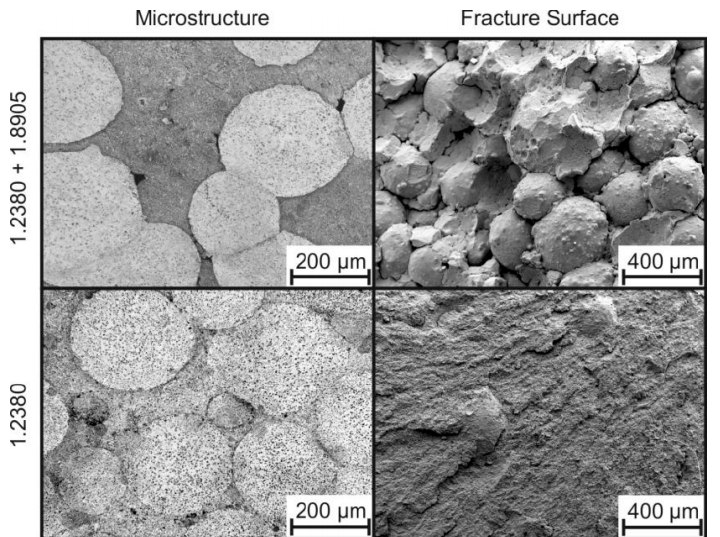
Figure 8. Comparison of the microstructure and the fracture surface of 1.2380/1.8905 mixture and pure 1.2380 steel, consolidated by capacitor discharge sintering (CDS) at 7500 μ F and 24 V output voltage. Reprinted with permission from ref. [94] Copyright 2009 EPMA, ©Euro PM2009.